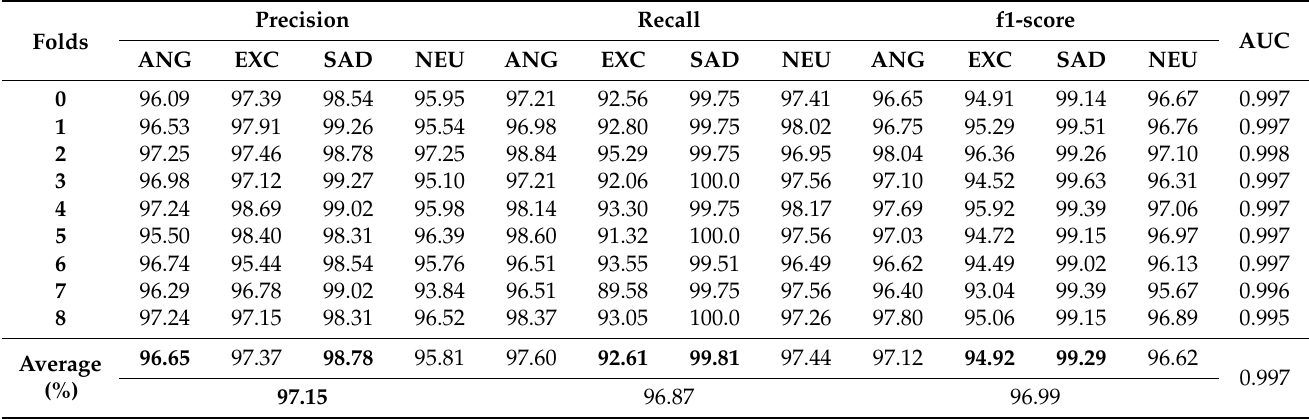
Table 6. Precision, recall, f1-score, and AUC for CNN model with 153 parameters. Precision Recall Folds